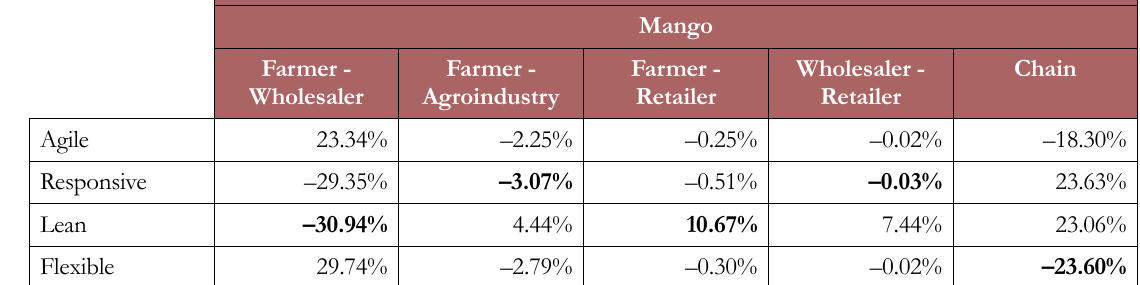
Table 6a. Waste Transport for Mango